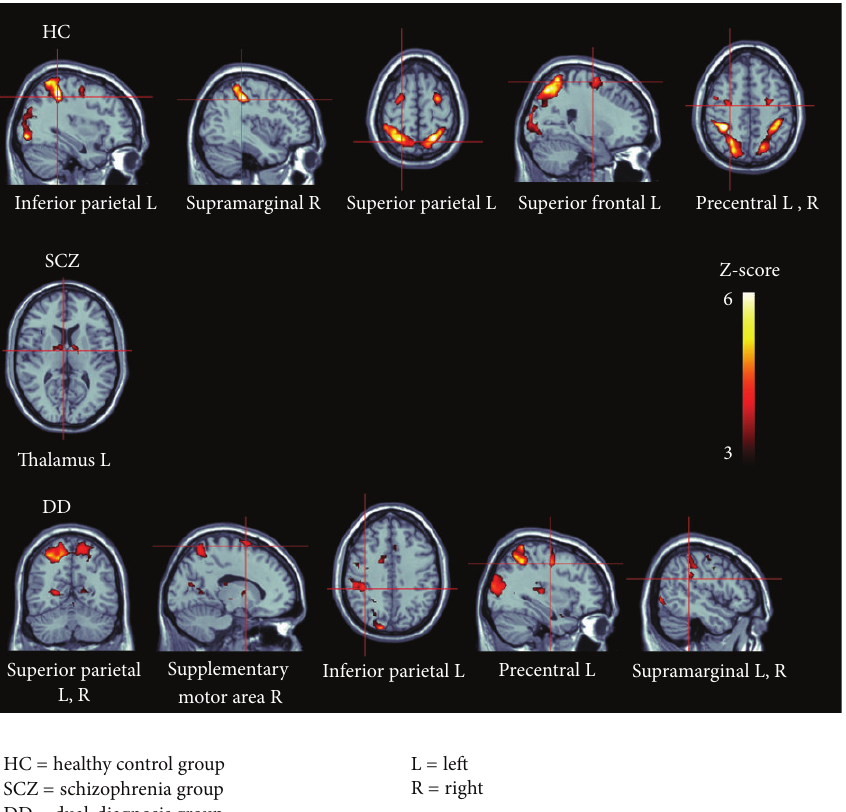
Figure 1: ROI brain activity when processing the mental rotation task in the 3 groups. HC: healthy control group; SCZ = schizophrenia group; DD = dual-diagnosis group; L = left; R =